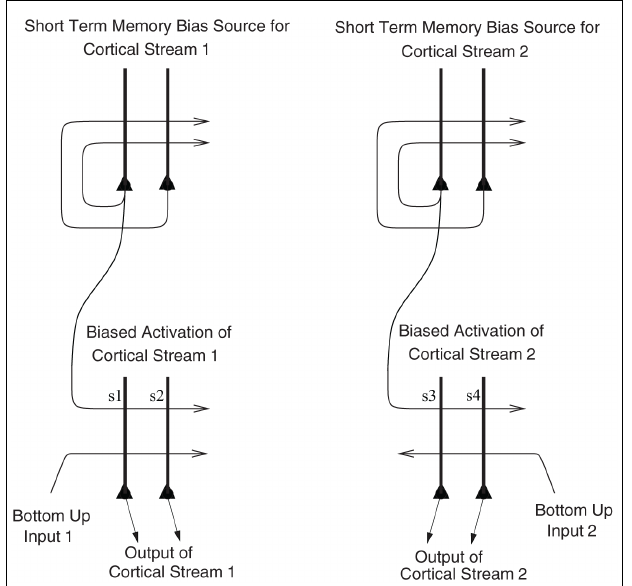
FIGURE 8 | Biased activation theory of top-down selective attention. The short-term memory systems that provide the source of the top-down activations may be separate (as shown), or could be a single network with different attractor states for the different selective attention conditions.The top-down short-term memory systems hold what is being paid attention to active by continuing firing in an attractor state, and bias separately either cortical processing system 1, or cortical processing system 2 via synapses labeled s .This weak top-down bias interacts with the bottom-up input to the cortical stream and produces an increase of activity that can be supralinear (Deco and Rolls, 2005b).Thus the selective activation of separate cortical processing streams can occur. In the example, stream 1 might process the affective value of a stimulus, and stream 2 might process the intensity and physical properties of the stimulus.The outputs of these separate processing streams then must enter a competition system, which could be for example a cortical attractor decision-making network that makes choices between the two streams, with the choice biased by the activations in the separate streams. (After Grabenhorst and Rolls, 2010).